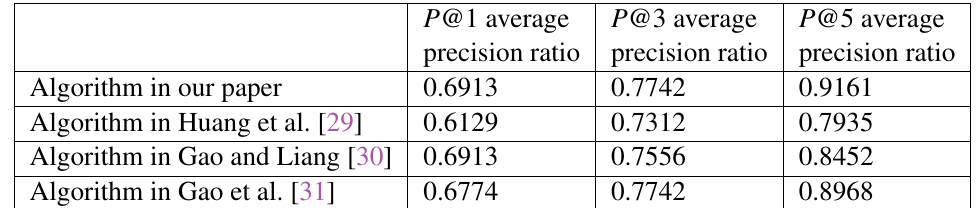
Table 2. The experiment results of ontology mapping